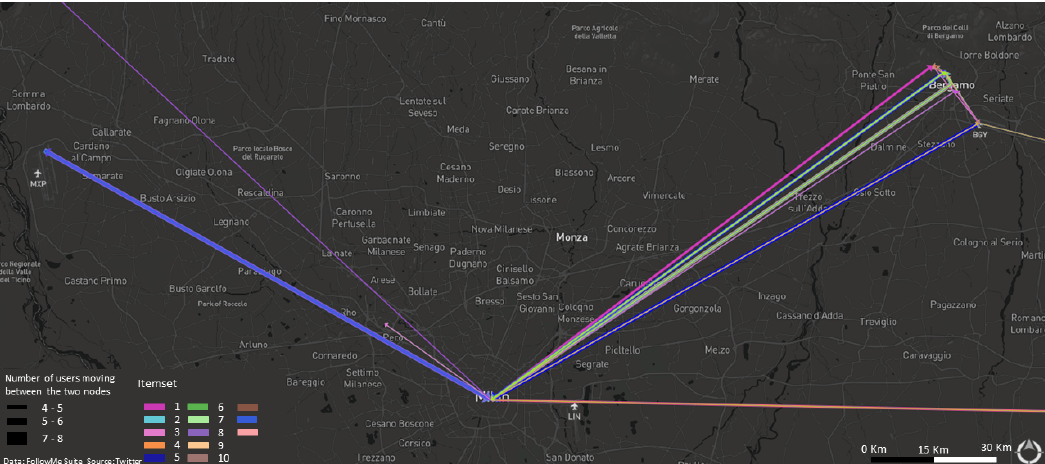
Figure 8. Topographic representation for discovered itemsets associating indirect transfers (Interpretation 3), focused at the level of surrounding regional territory of